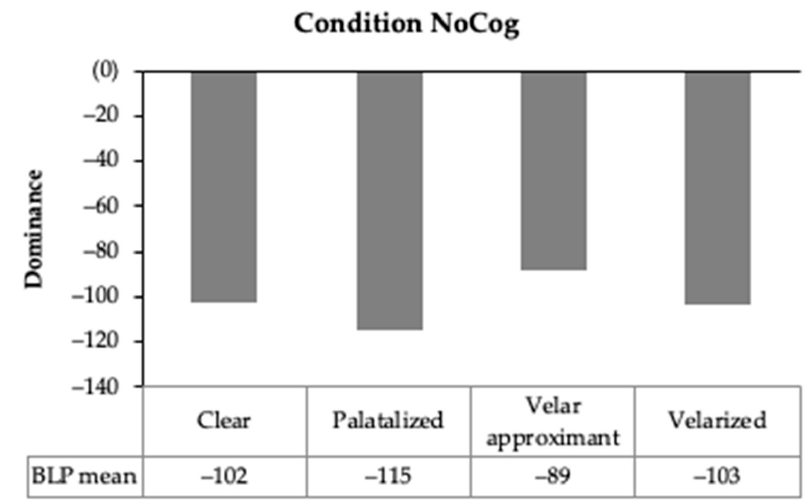
Figure 10. The interaction effect of condition NoCog and language dominance.